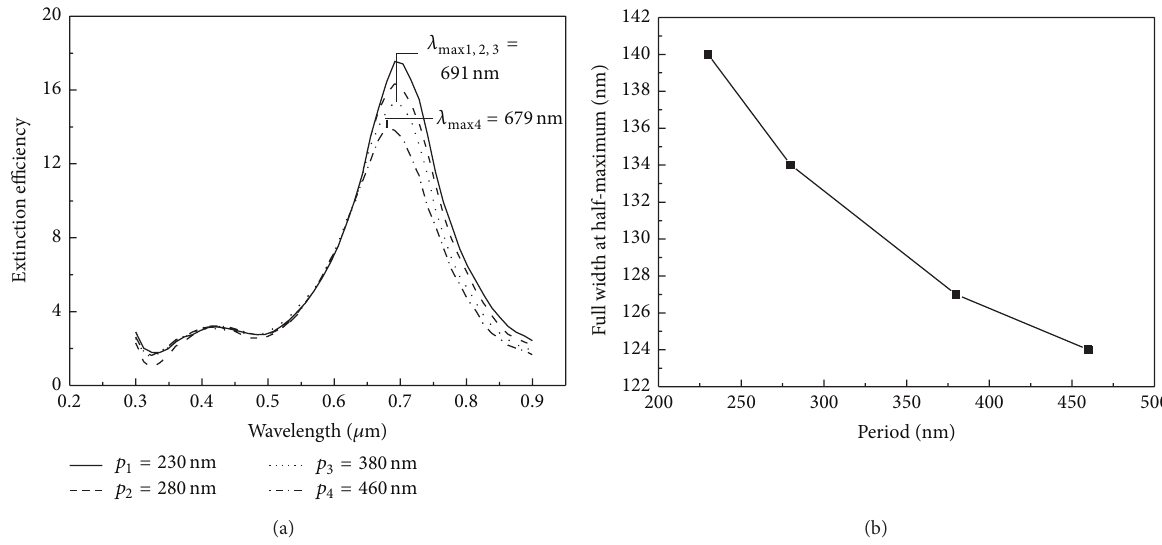
Figure 5: (a) Extinction spectra of triangular Ag nanoparticle arrays for different periods with fixed thickness of 40 nm. (b) Relationship between the peaks of wavelength and the periods of triangular Ag nanoparticles.